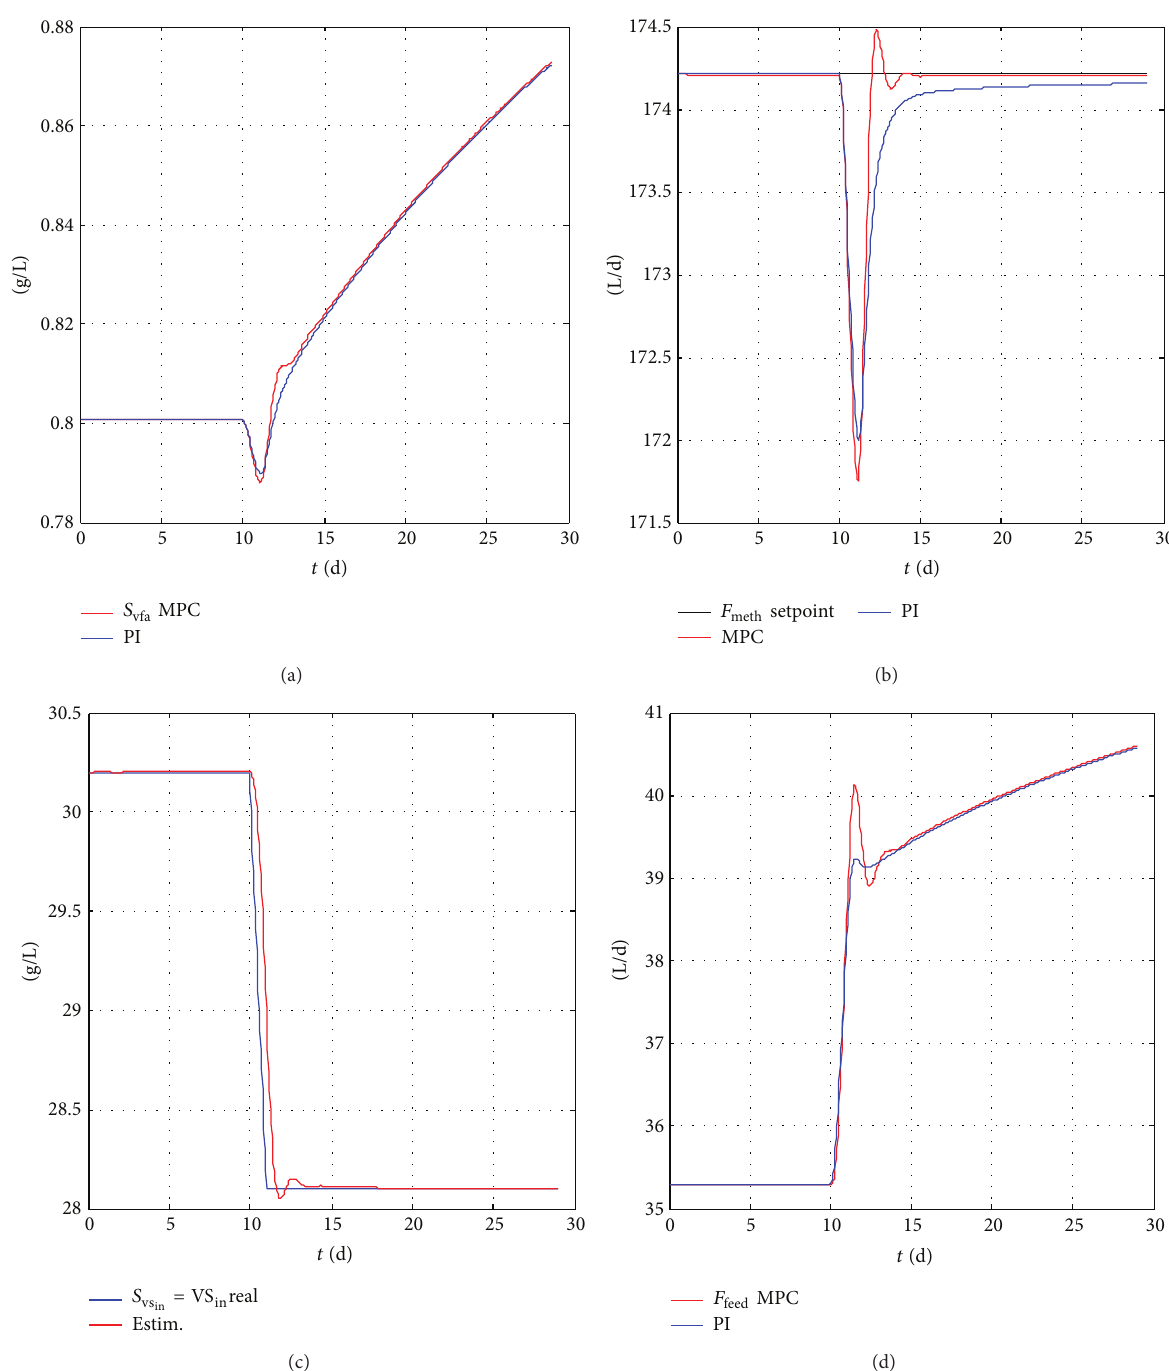
Figure 10: Predictive control and PI control of 𝐹 are and 𝑆 vs in